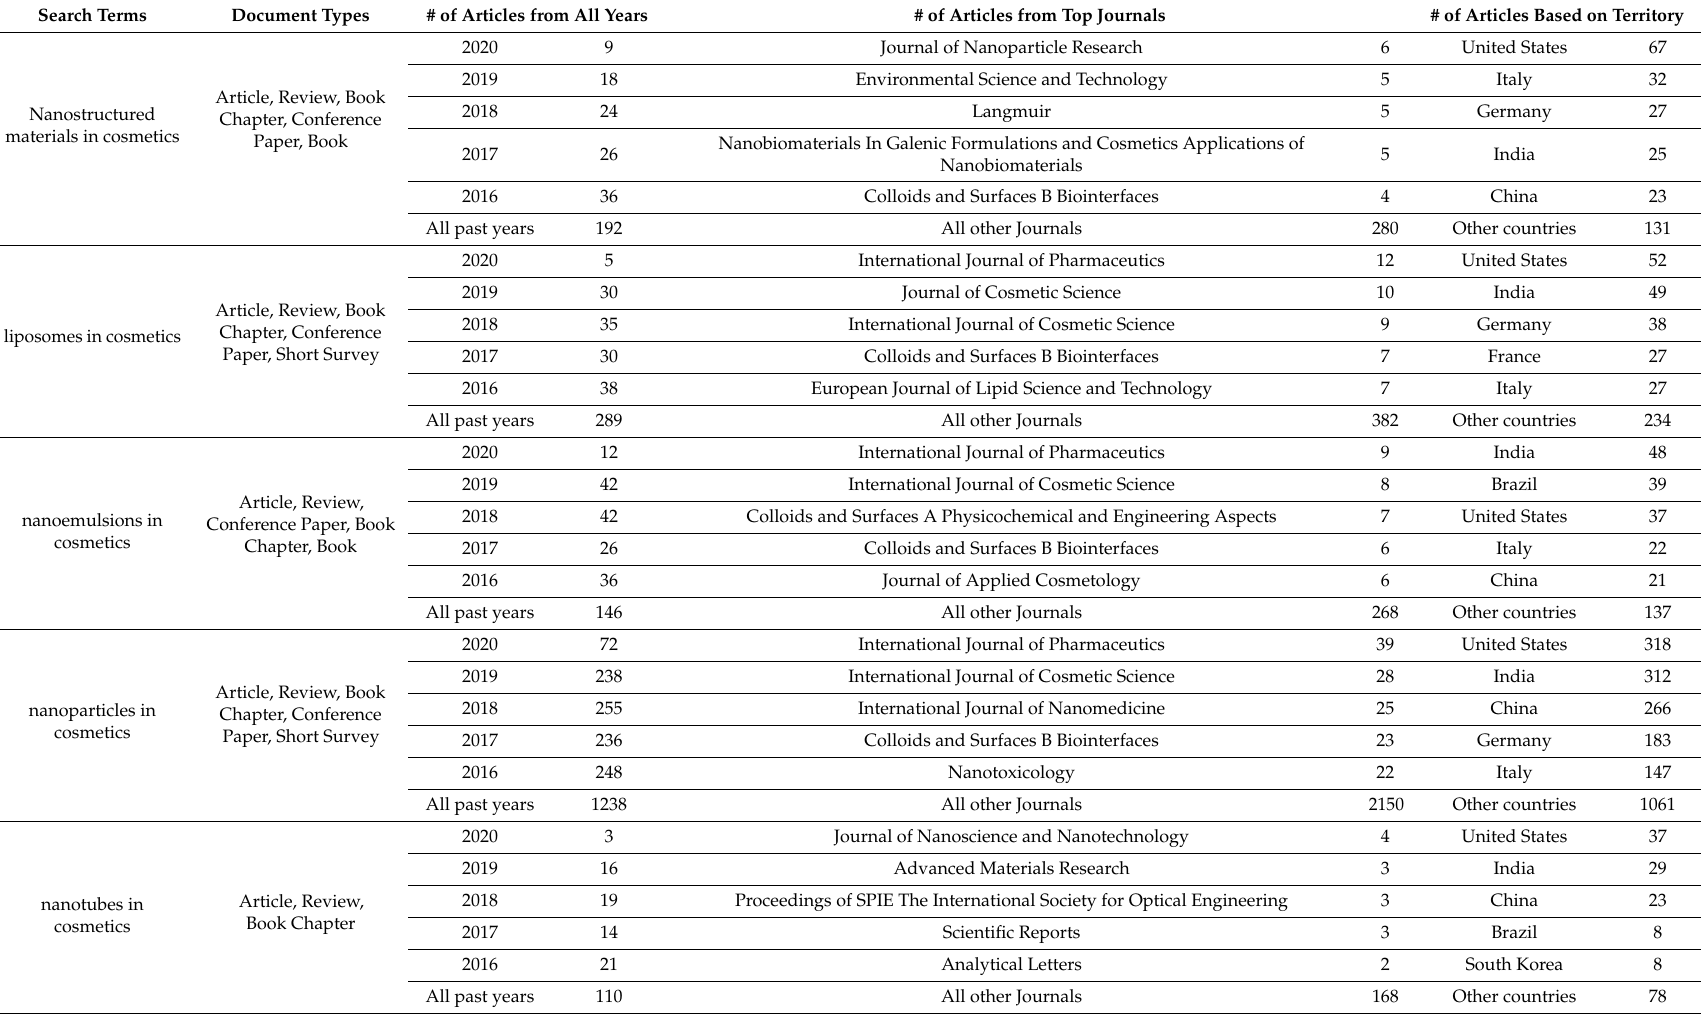
Table 1. The search terms and data statistics obtained from the